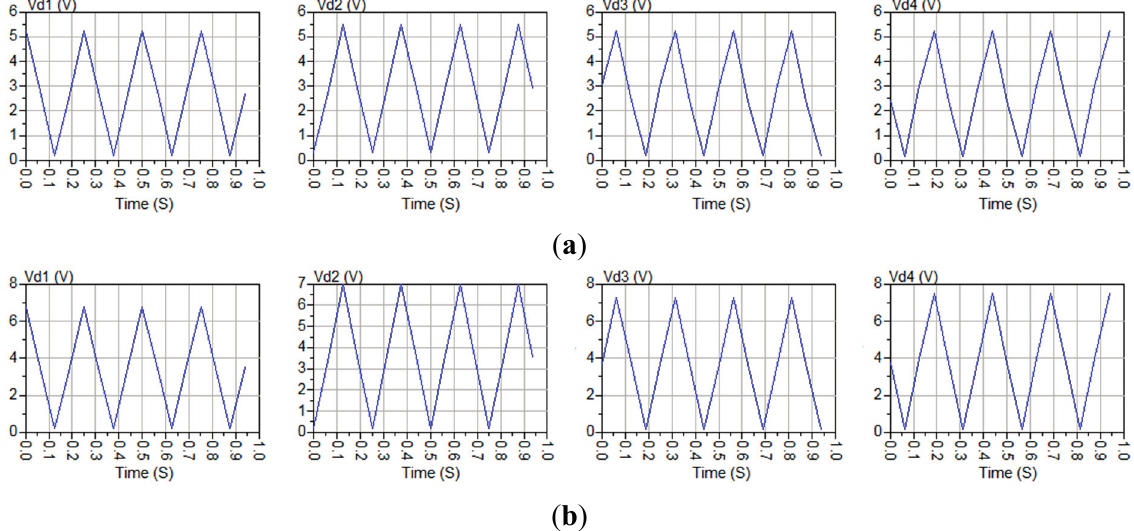
Figure 8. Optimized parametric model simulation results. ( a ) Fit of the situation in Figure 5a; ( b ) Fit of the situation in Figure 6a.